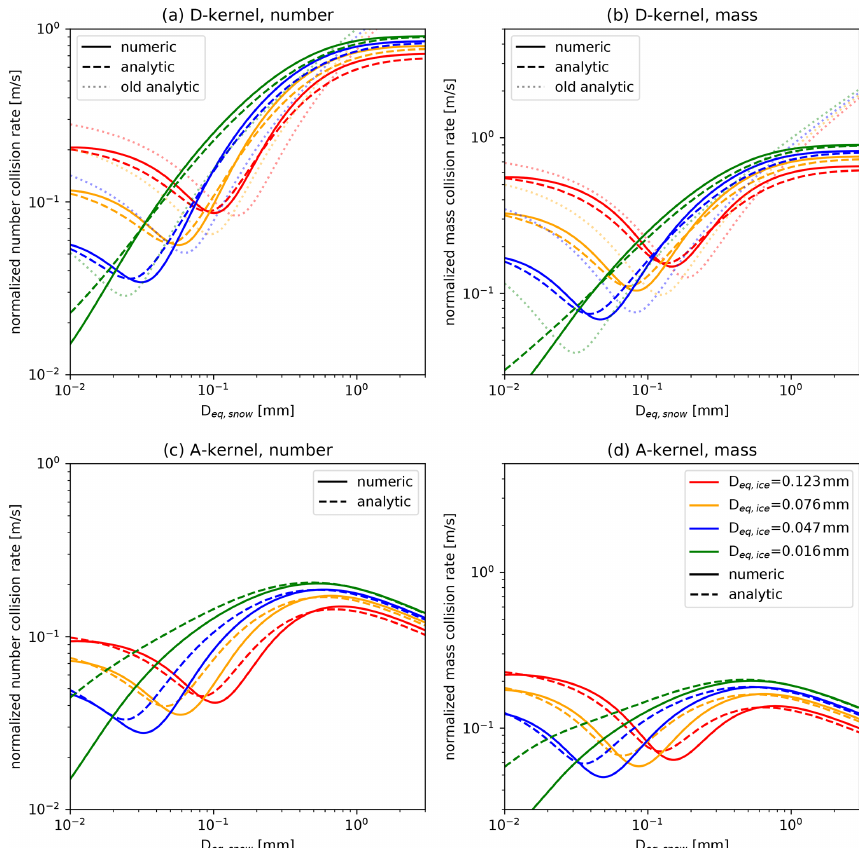
Figure B1. Numeric and analytic solution of the bulk collision rates for ice–snow (column and Mix2, respectively) collisions for Atlas-type and power-law velocity size relations. The shape parameter is µ eq = 2 (Eq. 7), which is equal to µ m = 0 (Eq. 5) for cloud ice and snow. Left: number density, right: mass density; top: D-kernel; bottom: A-kernel. (a, c) normalized number collision rate, (b, d) normalized mass collision rate, (a, b) D-kernel, (c, d)